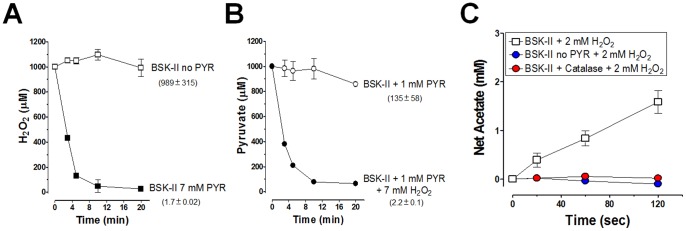
Pyruvate and H2O2 Produce Acetate.(A) One mM H2O2 was added to pyruvate-free BSK-II and standard BSK-II and H2O2 was measured over time using the xylenol orange/ferric iron assay [52]. (B) One mM pyruvate was added to pyruvate-free BSK-II. H2O2 (7 mM) was added and pyruvate was measured over time using a commerically available kit. Data shown are mean +/− SD (n = 3). The half-life values, in minutes, are shown in parentheses. (C) Production of acetate by pyruvate and H2O2 requires both reactants in BSK-II medium. The production of acetate was measured over time in BSK-II medium that contained pyruvate (7 mM), lacked pyruvate, and contained pyruvate with the addition of bovine catalase (200 U ml−1).